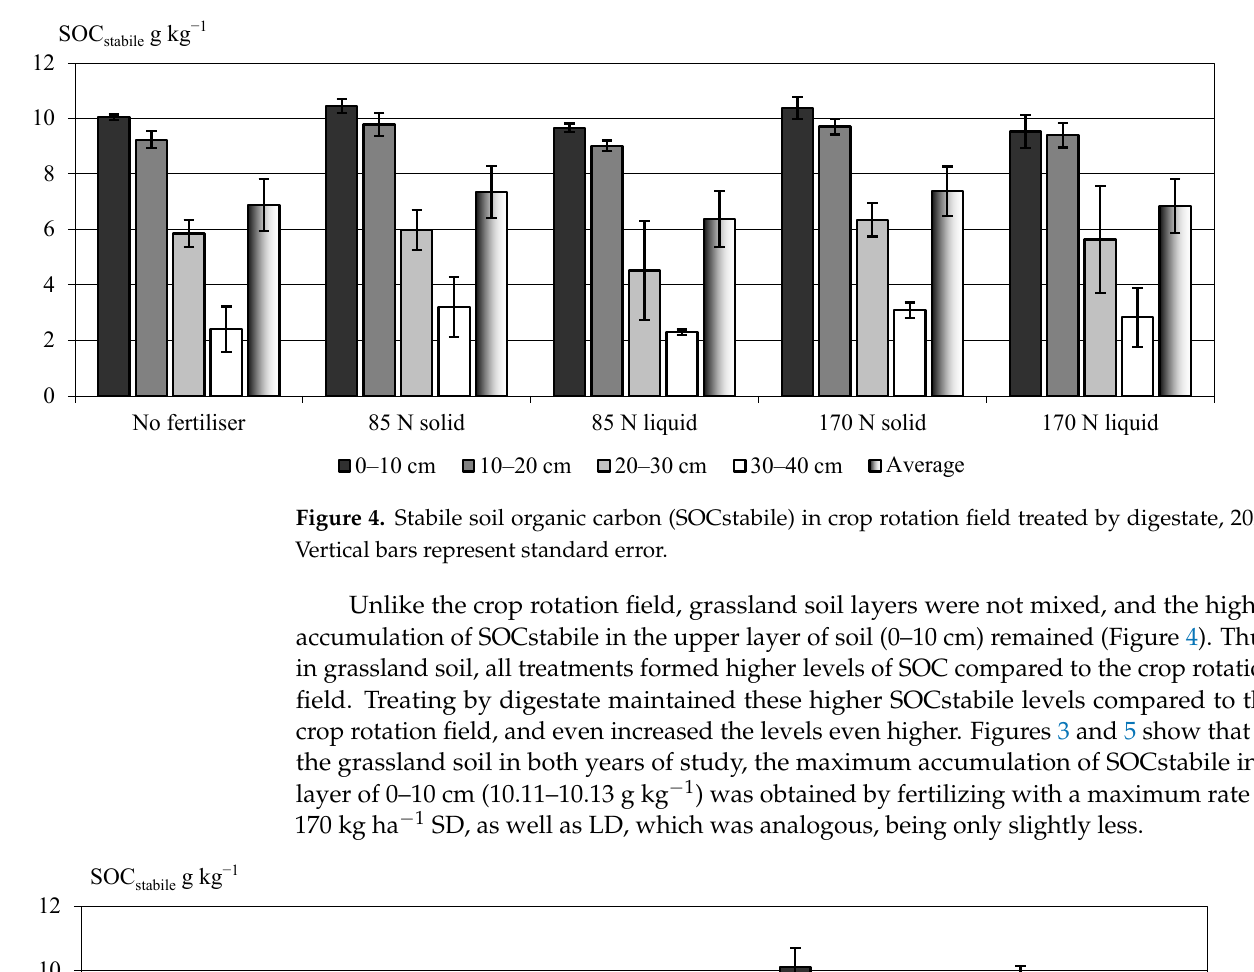
Figure 3. Stabile soil organic carbon (SOC stabile ) in grassland soil treated by digestate, 2019. Vertical bars represent standard error.